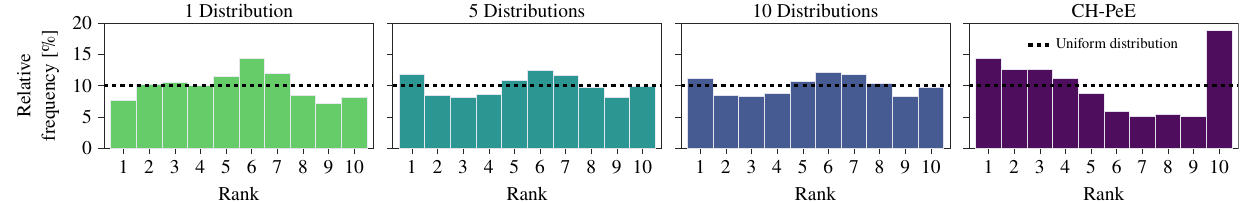
Figure 6. The rank histogram for different numbers of distributions at the output in comparison to the benchmark method. The predictions are reliable if the observed quantiles occur with a frequency equal to their nominal probabilities, which is illustrated by the dashed line. Deviations from the nominal distribution entail an under- or overestimation of the specific quantile. Hence, a ∩ -shape denotes overdispersed while a ∪ -shape denotes underdispersed predictions.